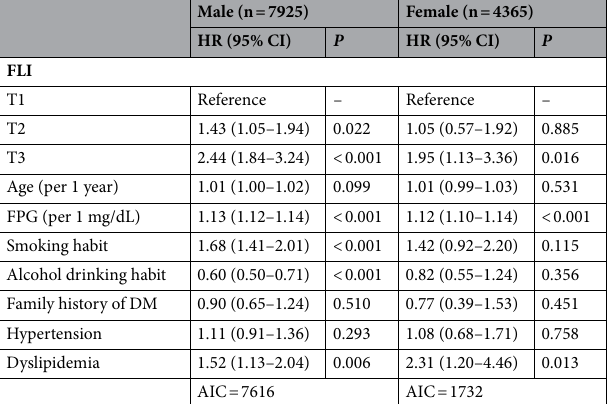
Table 4. Multivariable Cox proportional hazard analyses for new onset of DM in tertiles of FLI.